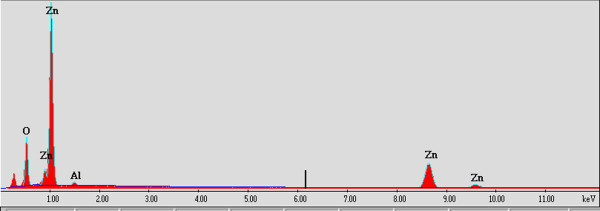
 EDS pattern of nanoparticles. EDS pattern of AZO:Y0.2 nanoparticles.